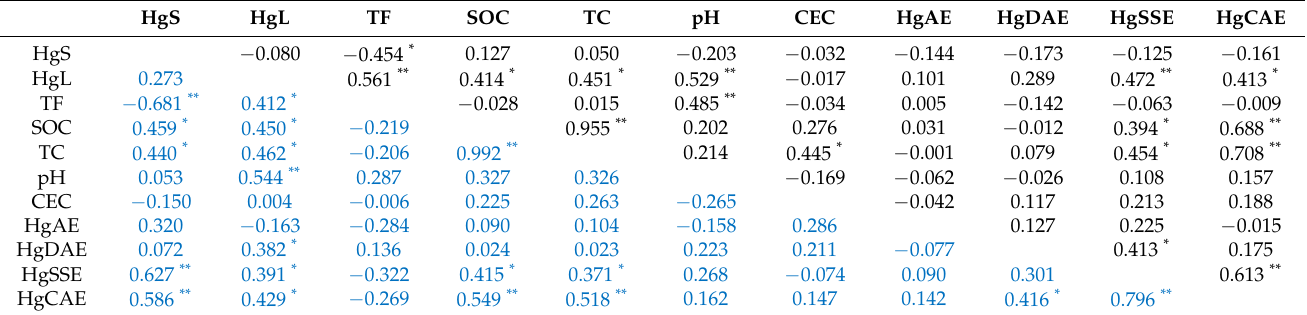
Table 7. Correlation coefficient between extraction amount of Hg and other indicators (N =